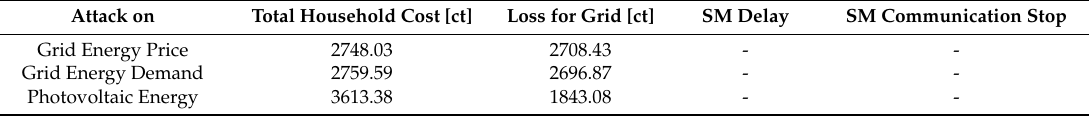
Table 7. Results of the simulation of integrity attack